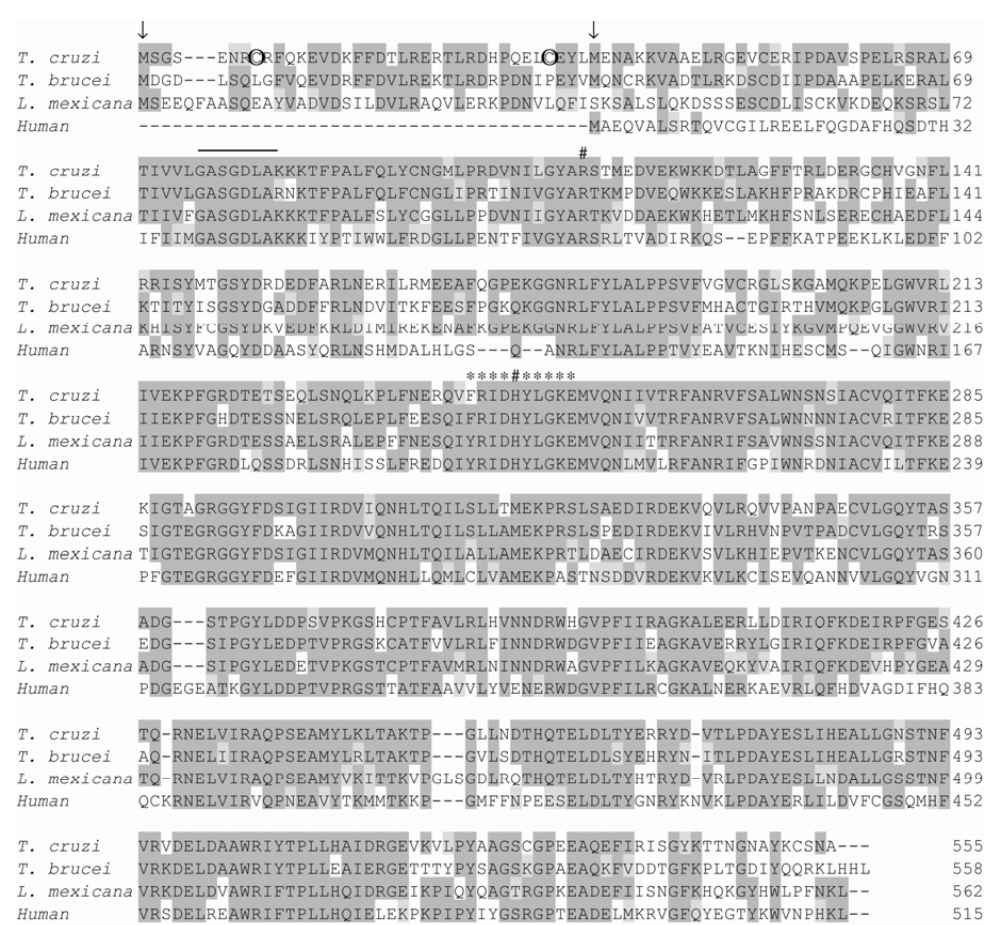
Fig. 2 – Alignment of the deduced amino acid sequences of different glucose 6-phosphate dehydrogenases. The sequences corresponding to the T. cruzi G6PDH (DQ408239) with the highest identity to its T. brucei counterpart, the T. brucei G6PDH (CAC07816), L. mexicana G6PDH (AAO37825) and human G6PDH (NP_000393) were aligned using the Clustal program. The first and second methionine in the T. cruzi and T. brucei sequences are marked with arrows. The two cysteine residues belonging to the T. cruzi N-terminal extension are circled. The cofactor binding site is overlined, and the sequence corresponding to the G6PDH signature, that is part of the substrate binding site, is marked with asterisks. Key residues involved in binding the substrate and cofactor are marked with